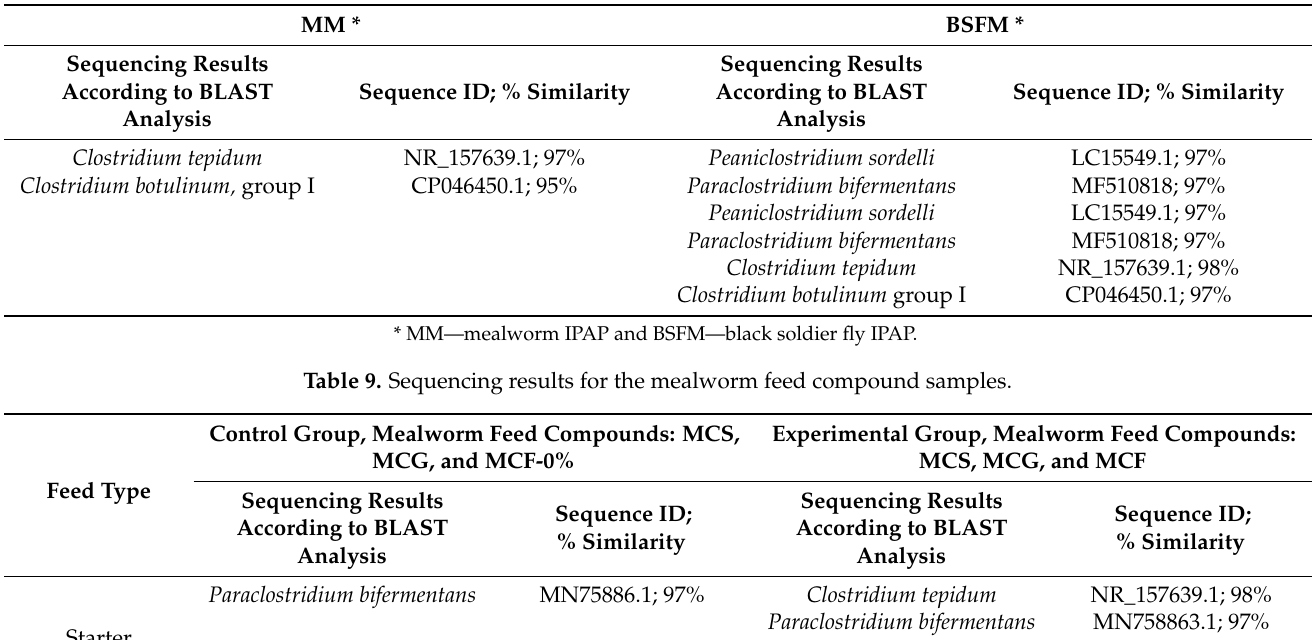
Table 8. Sequencing analysis results for the IPAP samples.